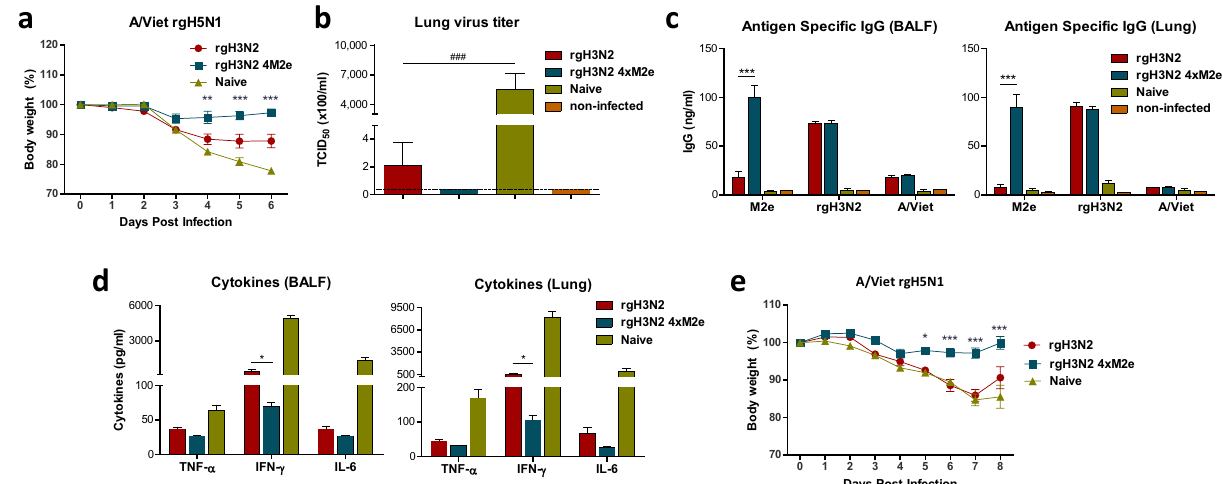
Figure 8. Boost with rgH3N2 4xM2e enhances cross protection against heterosubtypic A/Viet rgH5N1 virus by vaccination and immune sera. ( a , b ) Heterosubtypic cross protective efficacy of boost immune mice after challenge with rgH5N1 (A/Vietnam, 50 LD 50 ). ( a ) Weight changes of boost immunized mice (n = 5 /group) after rgH5N1 challenge. ( b ) Lung viral titers (TCID 50 × 100/ml) at 6-day post challenge with rgH5N1. ( c ) ELISA of IgG antibodies specific for M2e, rgH3N2, or rgH5N1 in BALF and lung extracts at day 6 post challenge with A/Viet rgH5N1. ELISA viral antigens are M2e peptide, rgH3N2 or A/Viet. ( d ) Inflammatory cytokines in BALF and lung extracts at day 6 post challenge with A/Viet rgH5N1. ( e ) Roles of boost immune sera in cross protection against rgH5N1 virus as determined by monitoring weight changes. Naïve mice (n = 3 /group) were intranasally inoculated with rgH5N1 (2 LD 50 ) virus mixed with boost immune sera (rgH3N2, rgH3N2 4xM2e) or unvaccinated naïve sera. Error bars indicate mean ± SEM. The statistical significances between rgH3N2 group versus rgH3N2 4xM2e group were determined using two-way ANOVA ( a , c – e ) or one-way ANOVA ( b ) and indicated in *, P < 0.05; **, P < 0.01; ***, P < 0.001; ### , P < Boost dose of rgH3N2 4xM2e enhances cross protection and correlates with higher M2e spe‑ cific IgG levels and lower inflammatory cytokines in the respiratory sites. At 3 weeks after boost dose, rgH3N2 and rgH3N2 4xM2e immunized mice were treated with T cell depleting anti-CD4 and anti-CD8 antibodies and then challenged with A/Phil H3N2 at a high dose. The rgH3N2 4xM2e group showed 100% protection without weight loss whereas the rgH3N2 group displayed substantial weight loss (15%) after A/Phil challenge (Fig. 7c). Consistent with efficacy of cross protection, inflammatory cytokine IL-6 levels were low in BALF and lung extracts from the rgH3N2 4xM2e group (Fig. 7d). Significantly higher levels of M2e specific IgG and IgA antibodies in BALF and lung extracts were induced in the rgH3N2 4xM2e group than those in the rgH3N2 group after A/Phil challenge (Fig. 7e–h). Also, the levels of IgA antibodies specific for rgH3N2 and A/ Phil viruses were higher in lung extracts from the rgH3N2 4xM2e group than those from the rgH3N2 group (Fig. 7h). Consistently, boost dose of rgH3N2 4xM2e also enhanced cross protection against heterosubtypic rgH5N1 virus, as shown by less weight loss (~ 4% versus 13% in rgH3N2 control) and undetectable lung viral loads (Fig. 8a,b). Particularly IgG levels specific for M2e were induced at significantly higher levels in BALF and lung extracts from the rgH3N2 4xM2e group than those in the rgH3N2 group or naïve group (Fig. 8c). IgG levels to vaccine (rgH3N2) and challenge virus (rgH5N1) were similar in both groups. As expected, the rgH3N2 and rgH3N2 4xM2e groups presented significantly lower amounts of TNF-α, IFN-γ and IL-6 than the naïve group after infection with rgH5N1 (Fig. 8d). Moreover, rgH3N2 4xM2e vaccine group exhibited lower levels of proin- flammatory cytokines (IFN-γ) compared to the rgH3N2 group. To determine the role and capability of immune sera in inducing cross protection against heterosubtypic rgH5N1 virus, naïve mice were intranasally infected with A/Vietnam virus (2 LD 50 ) after mixing with boost immune sera from the rgH3N2 and rgH3N2 4xM2e group, and naïve sera respectively (Fig. 8e). The group with rgH3N2 4xM2e immune sera displayed significantly less weight loss (~ 3%) compared to the rgH3N2 serum group with substantial weight loss (~ 15%) similar to the naïve serum group (Fig. 8e). At day 8 post challenge with rgH5N1 virus, the rgH3N2 group started to recover (Fig. 8e). Taken together, these results indicate that M2e specific antibodies in mucosal and systemic sites provide cross protection by restricting viral replication and preventing inflammation.